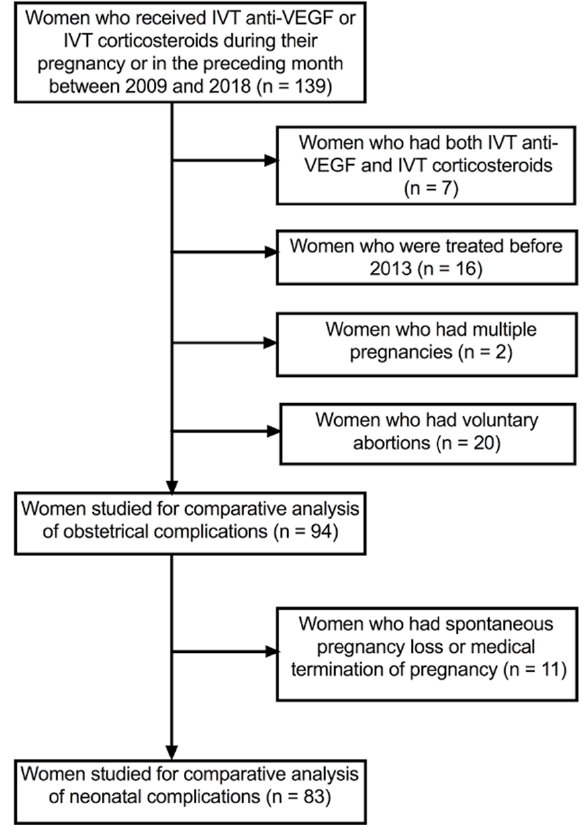
Figure 1. Flowchart of the study. Obstetric complications in 94 women were assessed after excluding women who had voluntary abortions. Spontaneous abortion or the medical termination of pregnancy occurred in 10 (16.1%) women who received anti-VEGF agents vs. 1 (3.1%) woman who received corticosteroid IVTs ( p = 0.09). Fetal lesions or fetal distress occurred in 11 (17.7%)